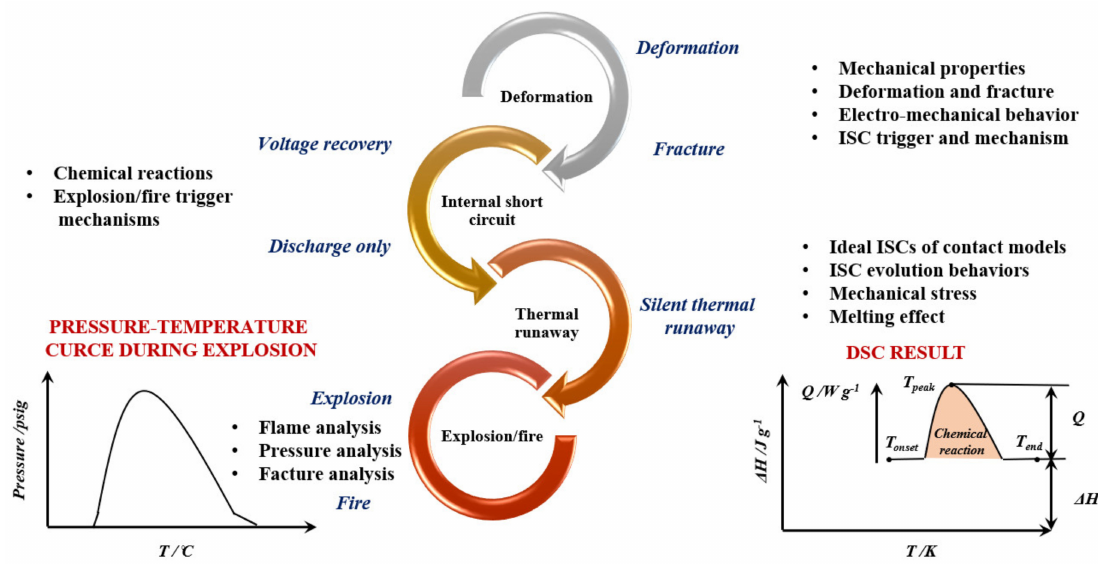
Figure 2. Typical milestone events of four phases: deformation, internal short circuit (ISC), thermal runaway, and explo- sion/fire, based